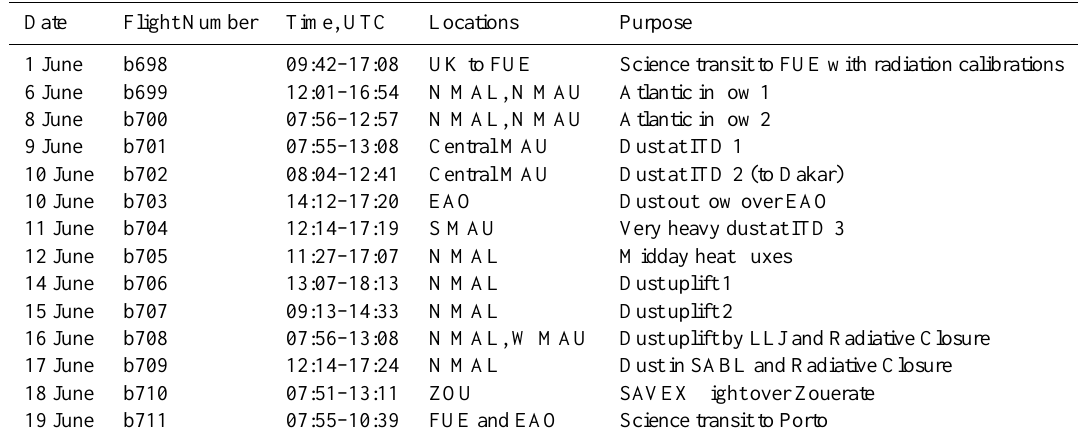
Table 7. June 2012 Fennec IOP